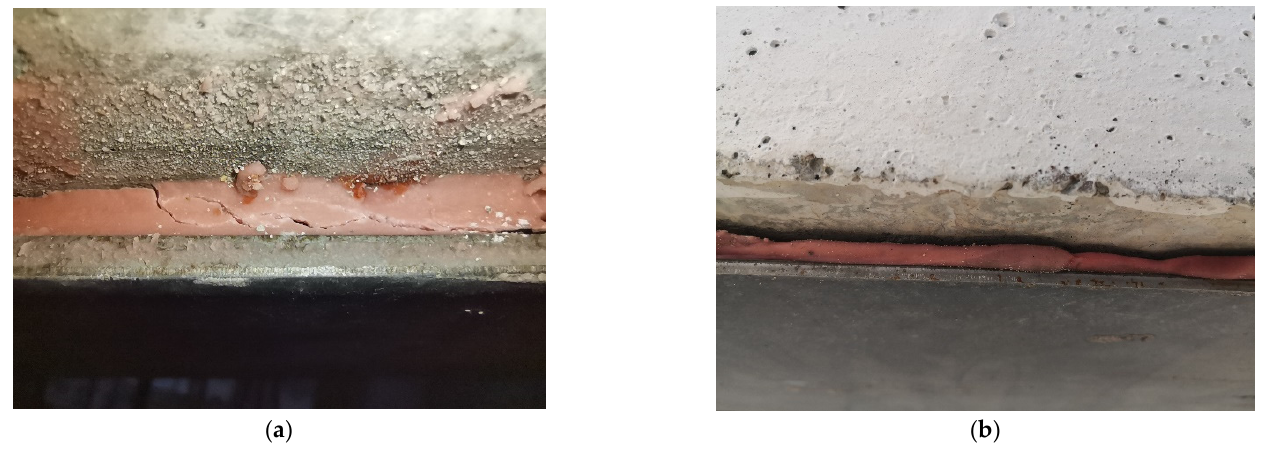
Figure 9. Failure modes of the adhesive layer. ( a ) Shear failure; ( b ) Separation failure of the bond- Figure 9. Failuremodesoftheadhesivelayer. ( a )Shearfailure; ( b ing interface.